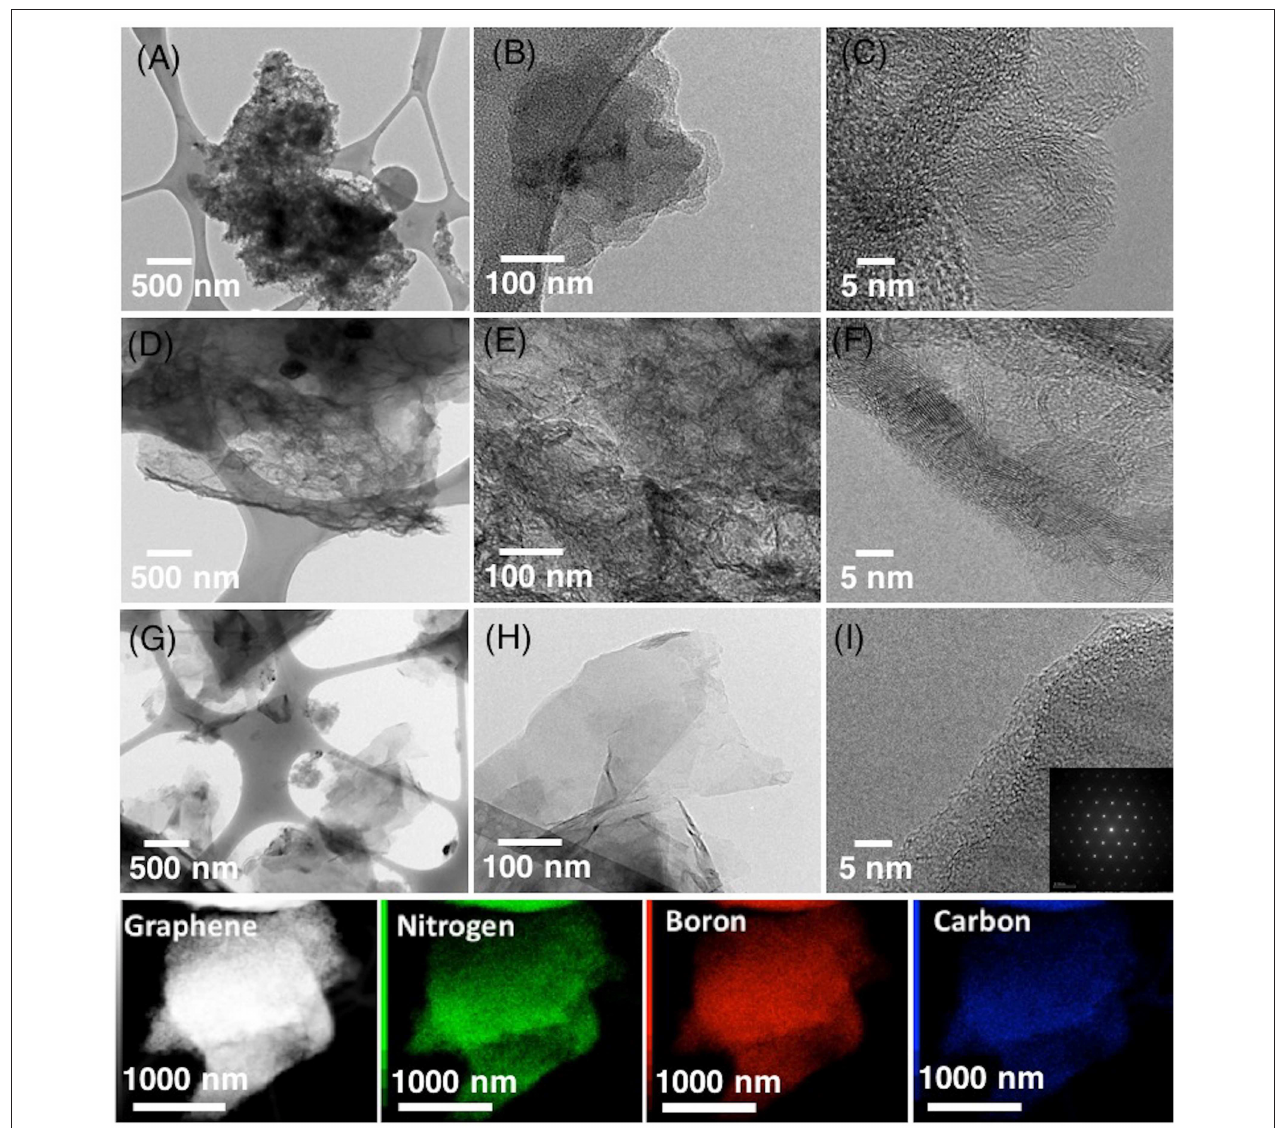
FIGURE 2 | The low and corresponding high-resolution TEM images of few-layered NB-GNs synthesized by SLPE in the presence of 5mM (A–C) , 2.5mM (D–F) , and 0.1mM sodium tetraphenylborate-NaBPh 4 (G–I) in 0.77mol ACN. The EDX mapping analysis showing the presence of N, B, and C in NB-GNs by SLPE, with a precursor containing 0.1mM NaBPh 4 in 0.77mol